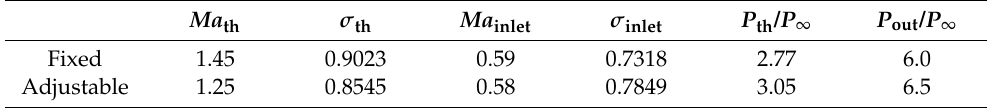
Table 3. Comparison of the parameters ( Ma ∞ =